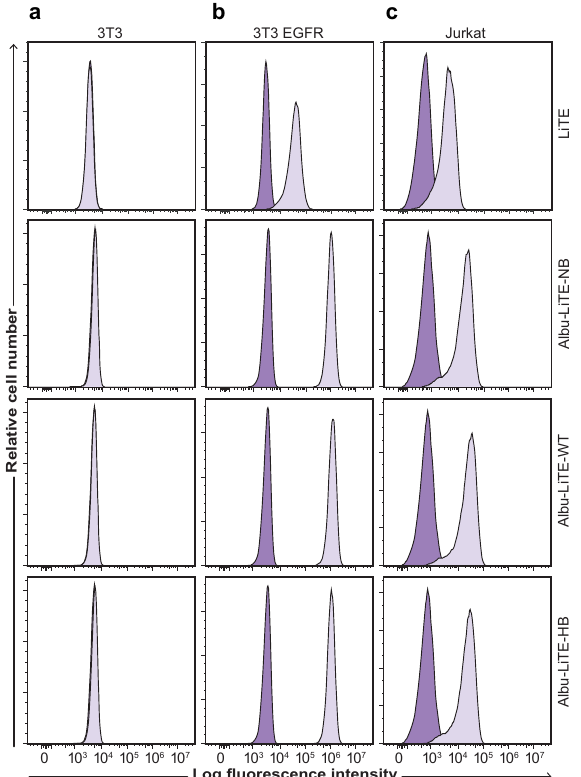
Fig. 4 Cell target binding properties of Albu-LiTE constructs. Flow cytometry analyses showing target-speci fi c binding with 5 µ g ml -1 of the LiTE (102 nM) and Albu-LiTE constructs (46 nM). The LiTE was detected by a C-terminal His-tag directed antibody, while the Albu-LiTE variants were detected using an anti-human serum albumin antibody. a No shift in fl uorescence intensity was observed for the double-negative 3T3 cell line, whereas, shifts in fl uorescence intensities were seen in b and c . b EGFR positive/CD3 negative 3T3 EGFR cells. c CD3 positive/ EGFR negative Jurkat T-cells. Isotype control antibody was used for background intensity